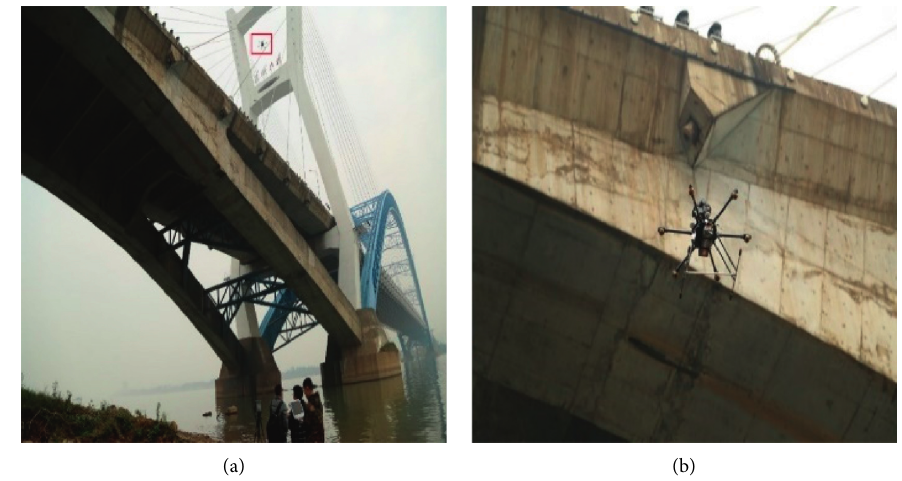
Figure 11: Bridge inspection process based on